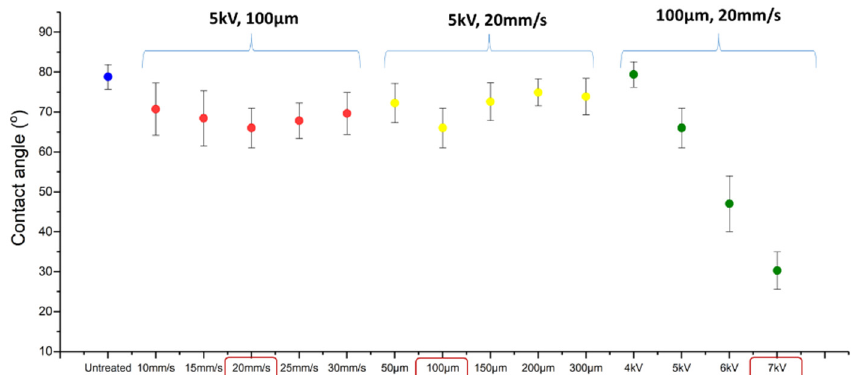
Figure 4. Contact angles of an untreated sample and µ Plasma treated samples with different processing parameters (printing rate, working distance and accelerating voltage).